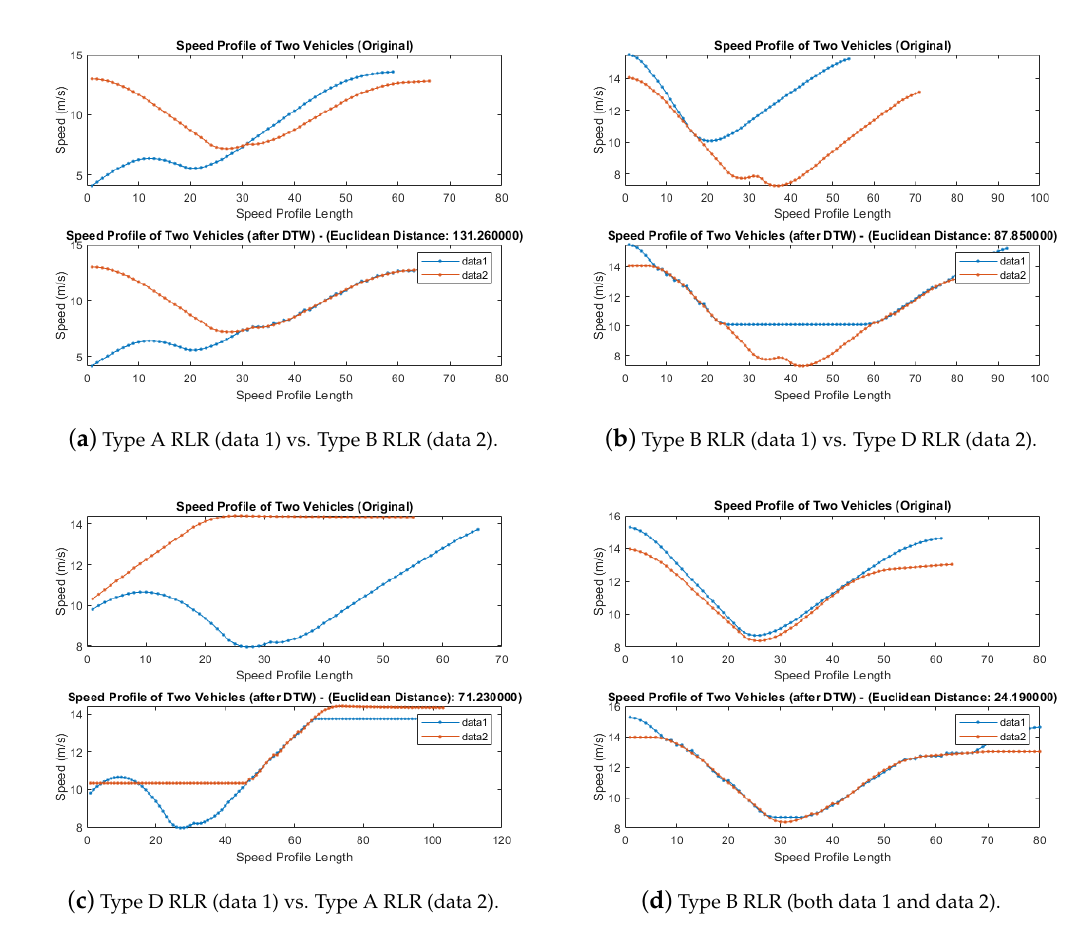
Figure 6. Examples of similarity results through the Dynamic Time Wrapping (DTW)